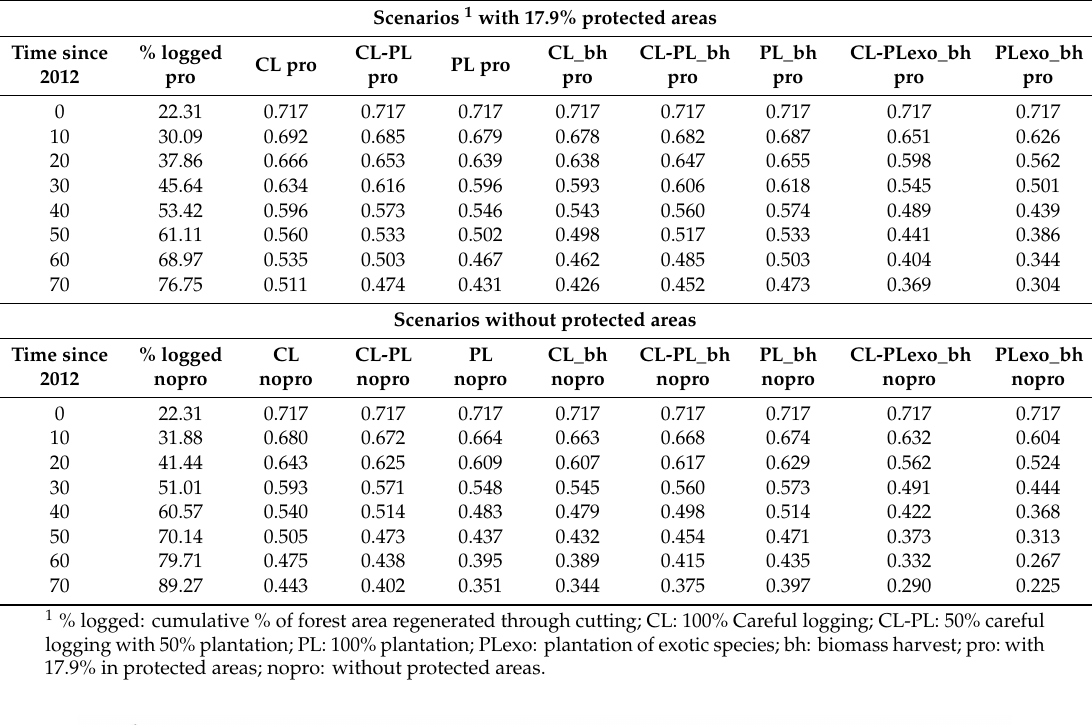
Table 9. Results of the 3 FMU scenarios over time.